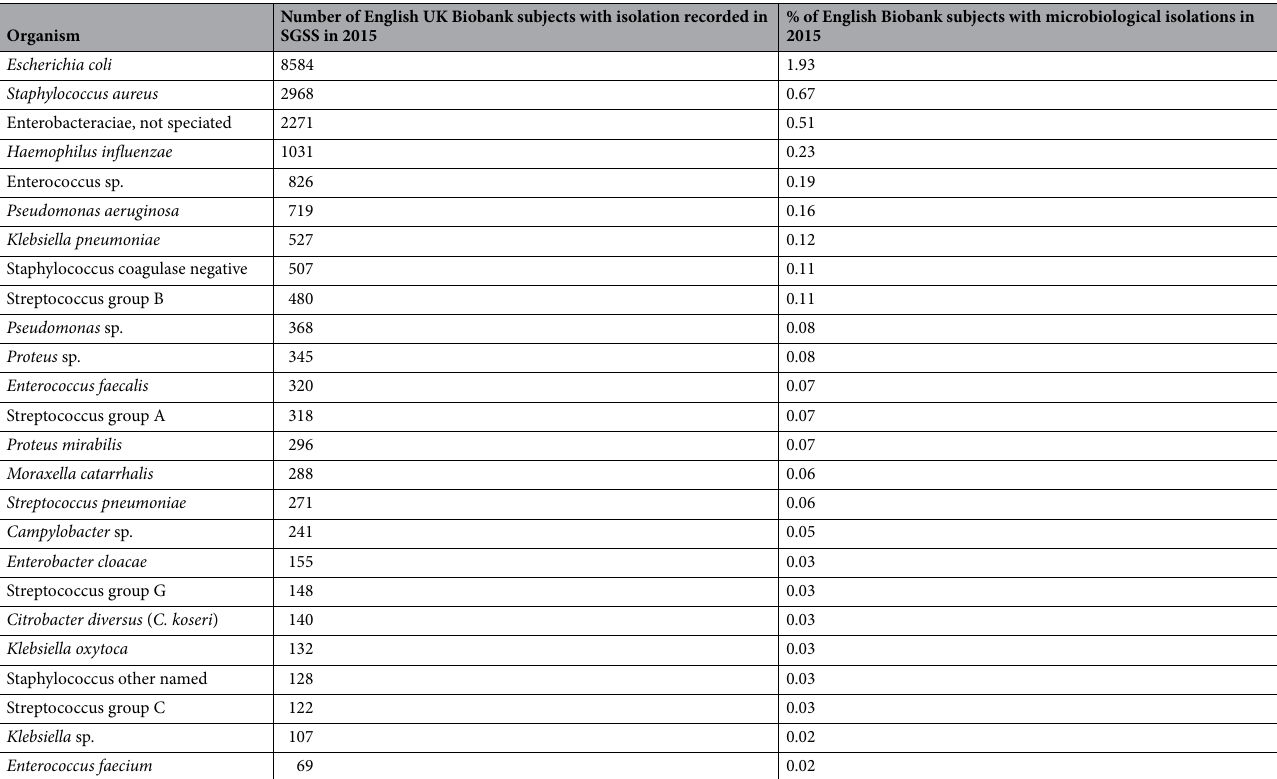
Table 1. The number of UK Biobank participants with microbial isolations recorded in SGSS in 2015 for the 25 most common organisms isolated. Note that one individual’s cultures can yield more than one different